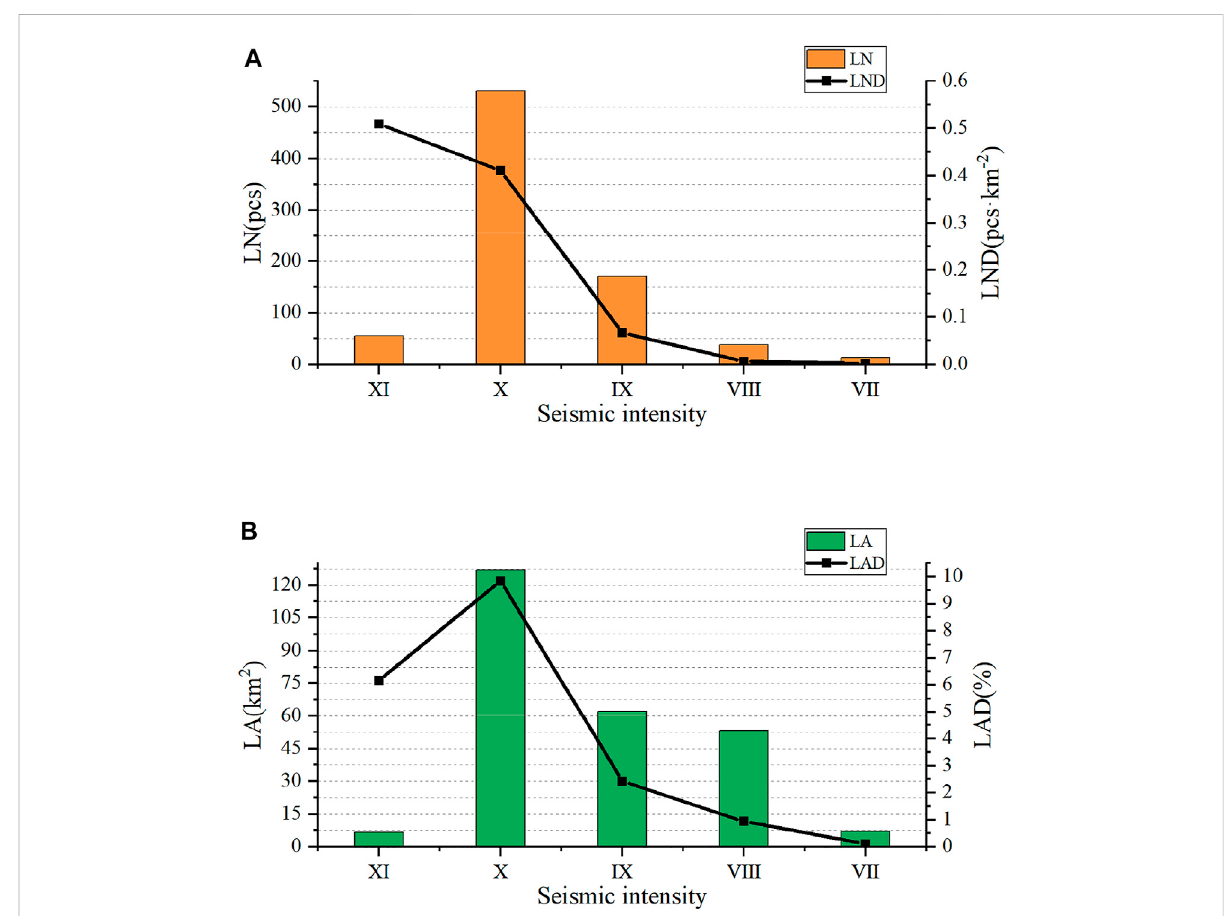
FIGURE 4 The correlations between seismic intensity and landslide distribution. (A) LN and LND; (B) LA and